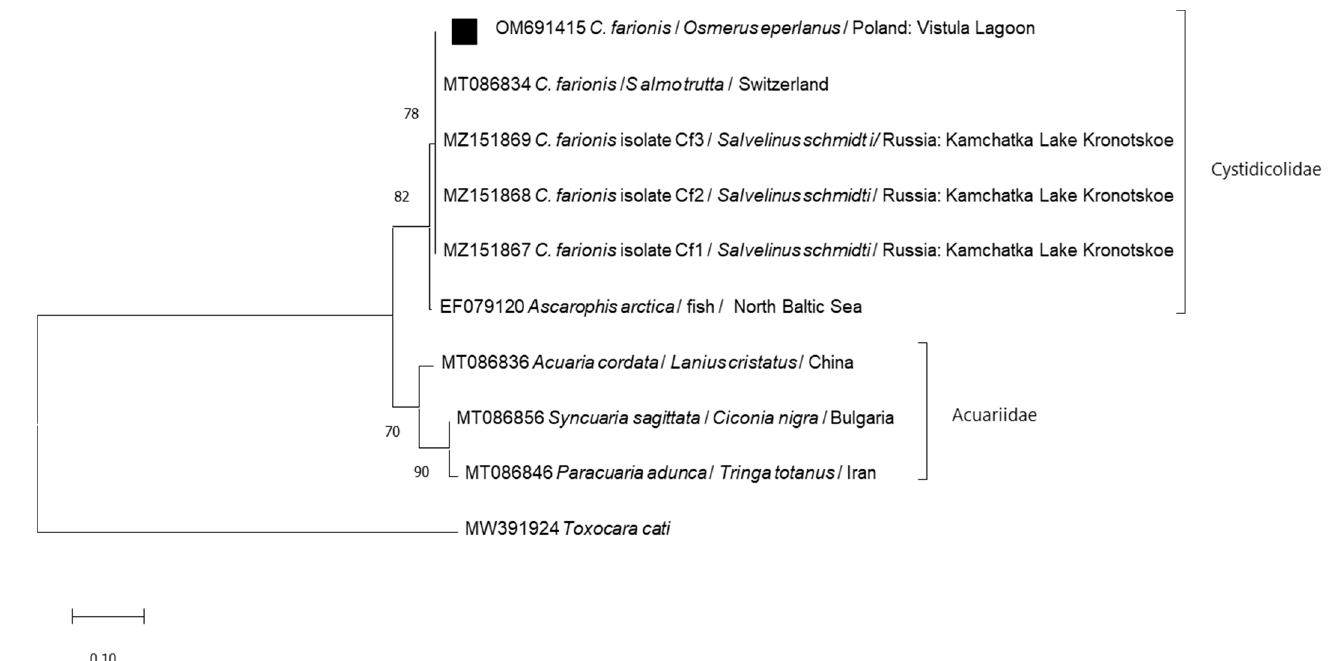
Figure 3. Molecular relationships of the sequence of the nuclear large subunit rRNA gene region (28S rRNA) of Cystidicola farionis identified in the study with other species from Cystidicolidae and Acuariidae. The phylogenetic tree was constructed using the neighbor-joining method and the Kimura 2-parameter as a distance method. Numbers at the tree nodes indicate the percent of bootstrap value from 1000 replicates. The tree is drawn to scale, with branch lengths measured in the number of base substitutions per site. Toxocara cati was used as an outgroup. The analyses were conducted in MEGA X. The sequence obtained in this study was labelled with black symbols.